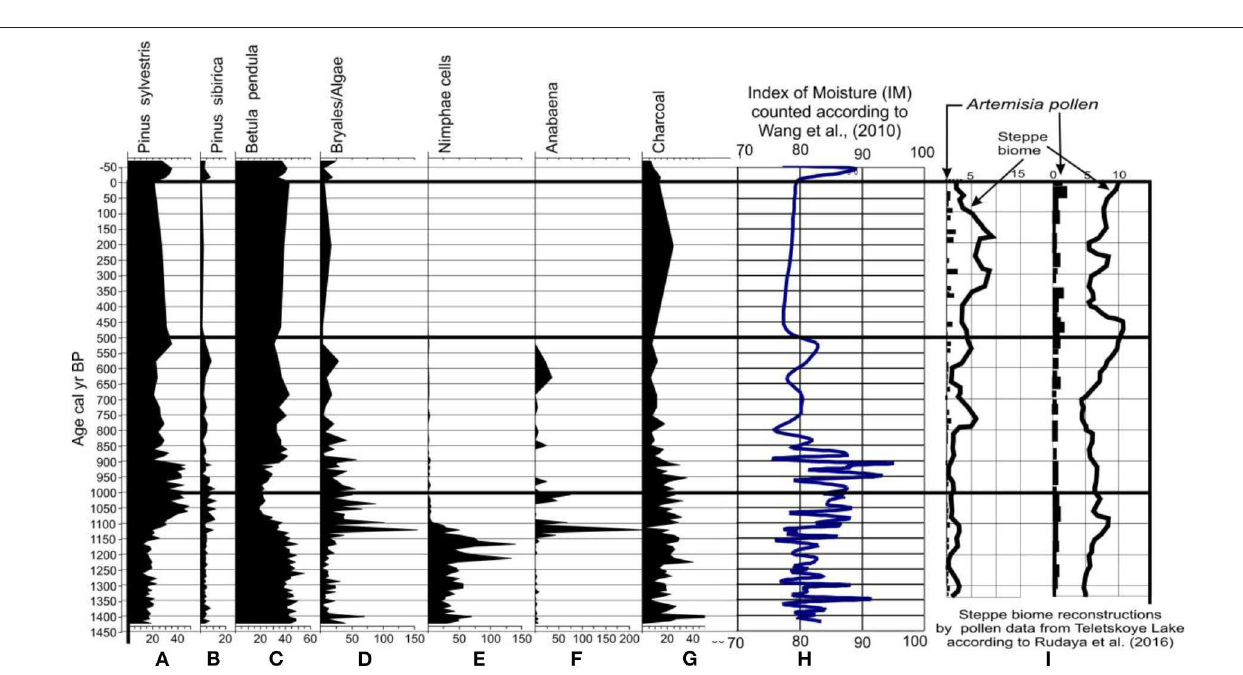
FIGURE 5 | Pollen diagram of Manzherok Lake on even time scale. The pollen types are presented in % from the pollen of terrestrial plants.